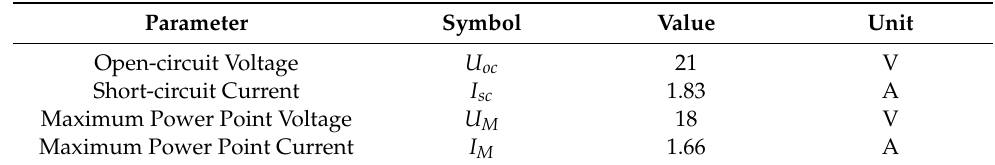
Table 1. PV Array